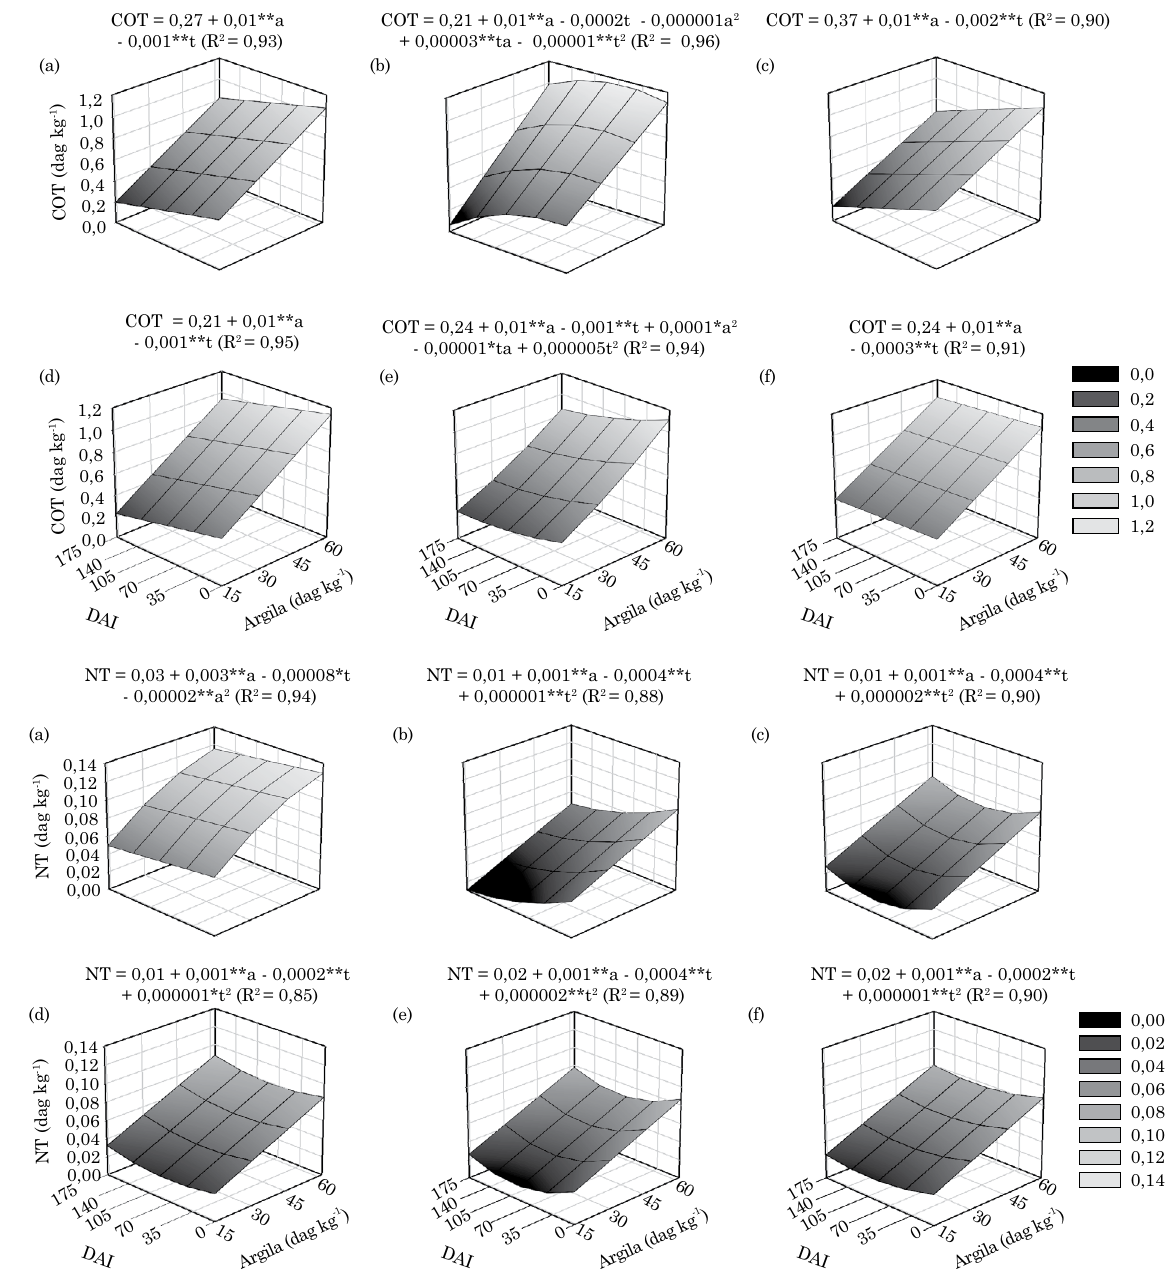
figura 1. carbono orgânico total (cot) e nitrogênio total (nt) nos solos com fontes inorgânicas dos nutrientes (a), sem adição de nutrientes e resíduo (b); e com resíduo de milho (c), braquiária (d), feijão (e) e estilosantes (f). * e **: significativos a 5 e 1 %, respectivamente, referentes às variáveis: a – teor de argila, t – tempo e ta – interação entre esses. DAI: dias após o início da